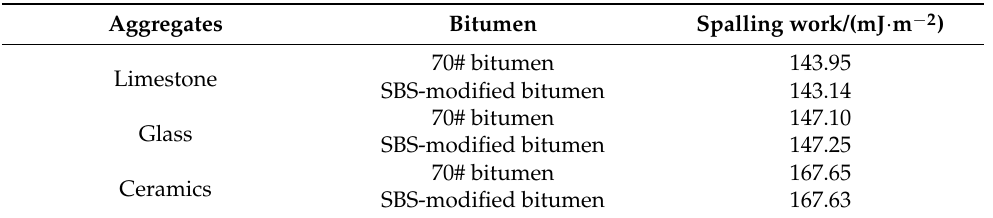
Table 10. Spalling work between bitumen and aggregates.